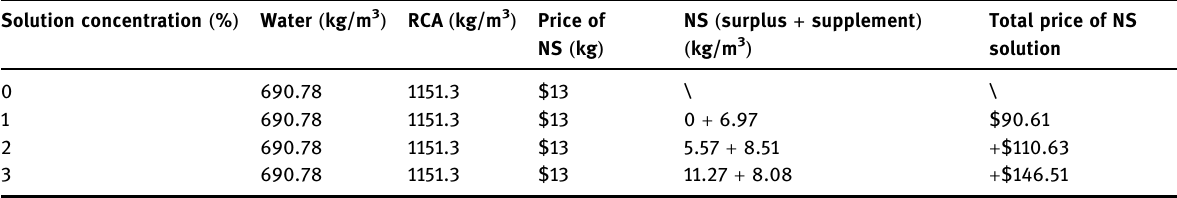
Table 4: : Price of the RCA soaked in NS solution Solution concentration ( % ) Water ( kg/m 3 ) RCA ( kg/m 3 ) Price